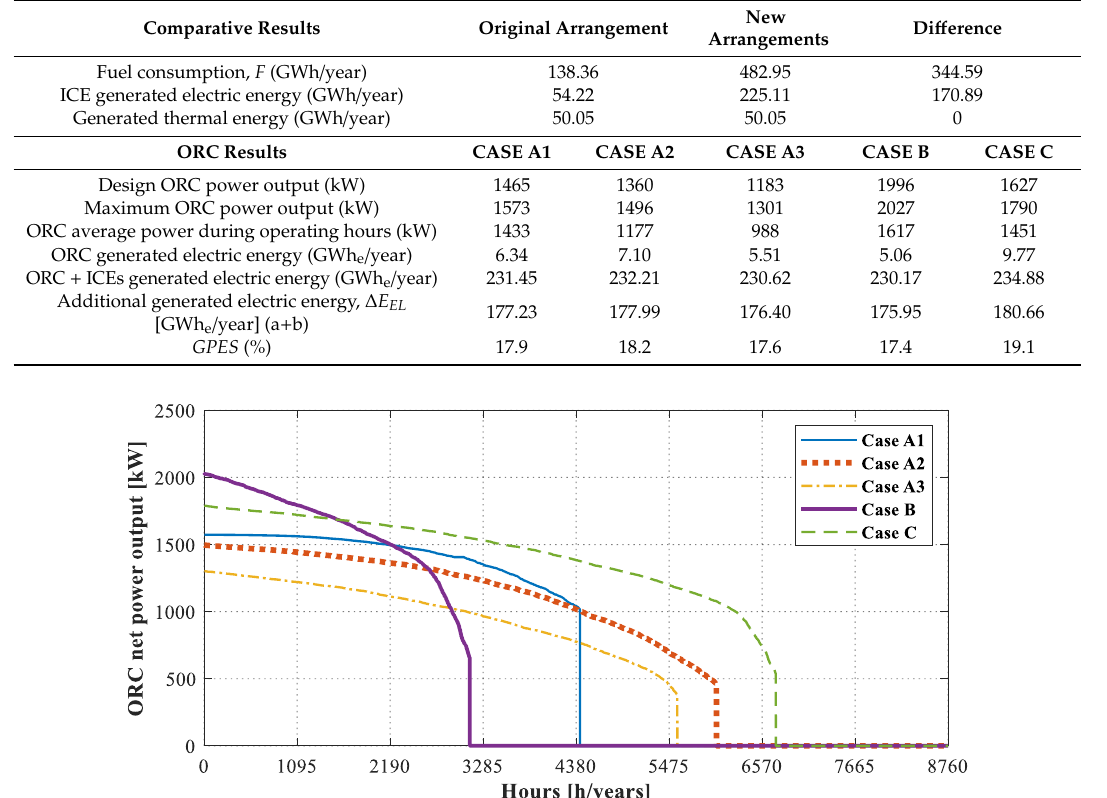
Table 7. Main energy results for the analyzed configurations.